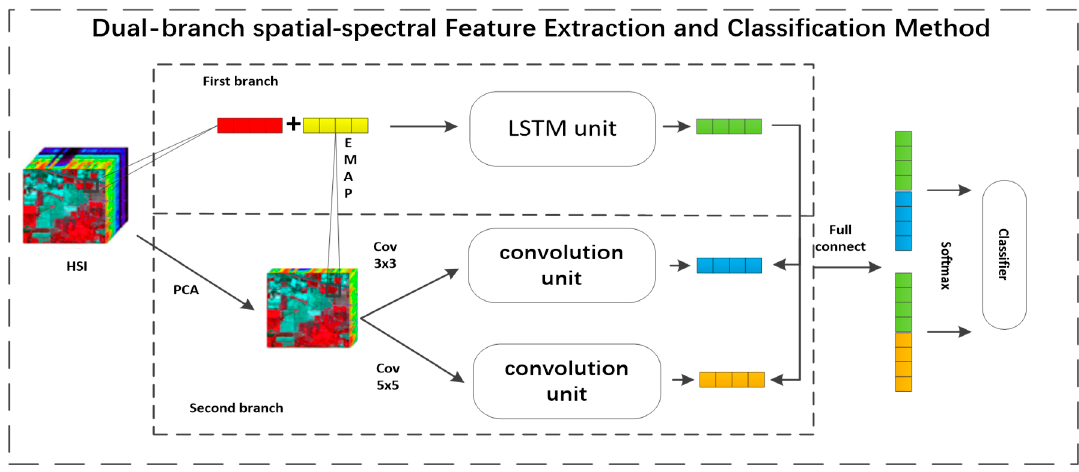
Figure 3. Schematic diagram of dual-branch spatial-spectral feature extraction and classification method. PCA: principle component analysis. LSTM: long short-term memory. EMAP: expanded multi-attribute morphological profile. Cov: convolution.